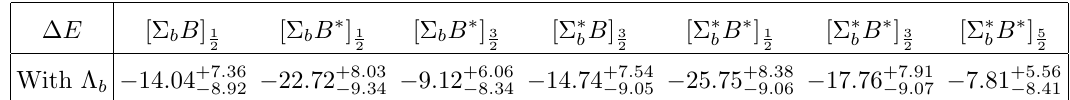
Table 4 . The binding energies (cid:1) E for the I = 1